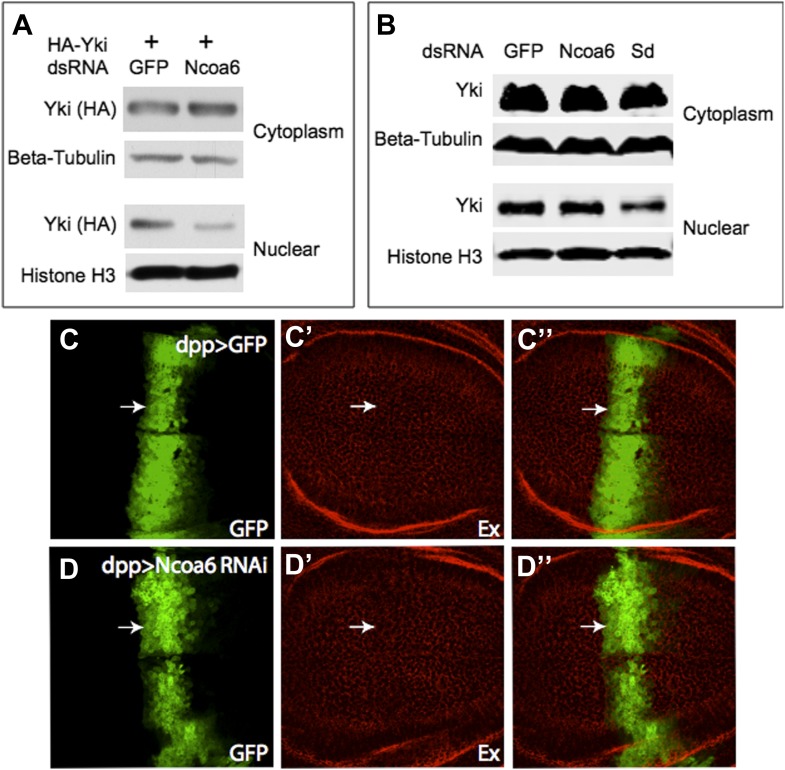
(A) Cell fractionation of S2R+ cells showing that RNAi knockdown of Ncoa6 modestly decreased HA-Yki in the nucleus, with a concurrent increase in the cytoplasm.(B) RNAi knockdown of Ncoa6 caused no obvious change in subcellular fractionation of endogenous Yki. Sd, which has been reported to promote Yki nuclear localization, was included as a control. Knockdown of Sd led to a modest decrease of nuclear Yki. (C-D) RNAi knockdown of Ncoa6 did not obviously affect the expression of Ex. Wing discs expressing UAS-GFP only (C) or UAS-GFP plus Ncoa6 RNAi (D) were stained for Ex. The complete genotypes are: UAS-Dicer2; dpp-Gal4 UAS-GFP (C), UAS-Dicer2; dpp-Gal4 UAS- GFP/UAS-Ncoa6RNAi (D).